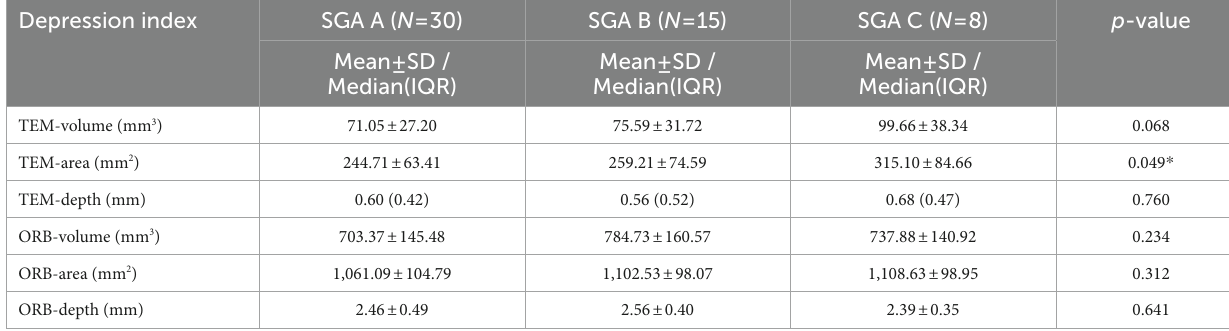
TABLE 2 Depression index differences among malnourished groups.